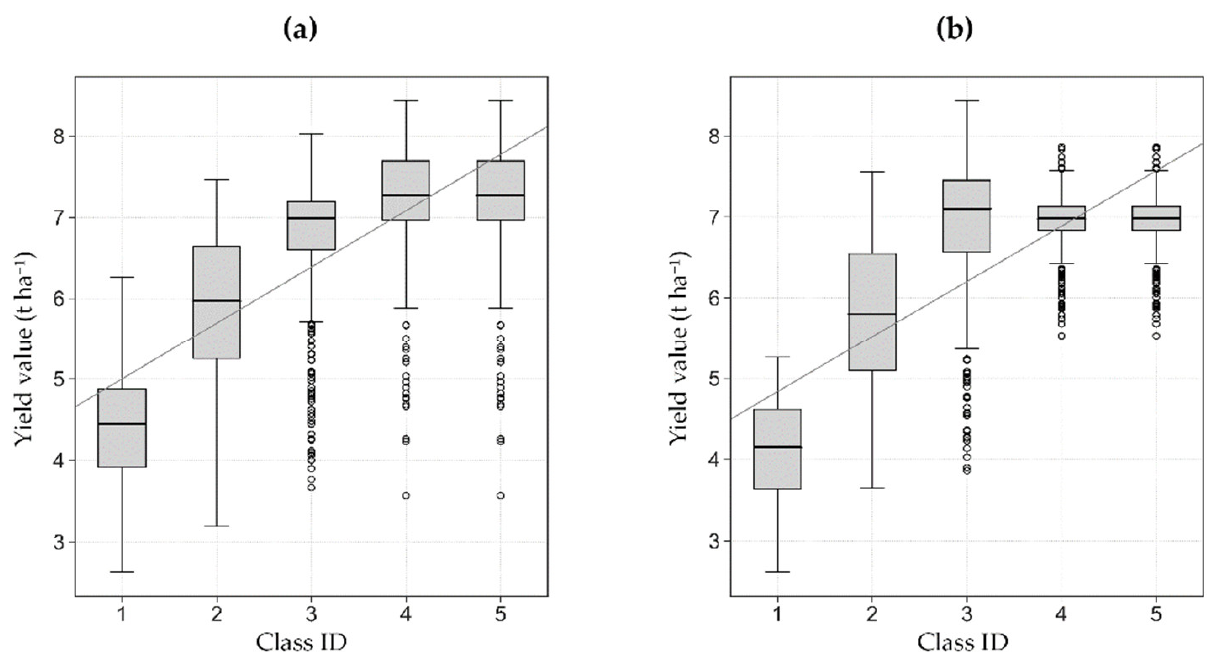
Figure 13. Delineated MZ maps of model-3 for fertilization at 25 March 2020 ( a ) and 21 April 2020 ( b ).